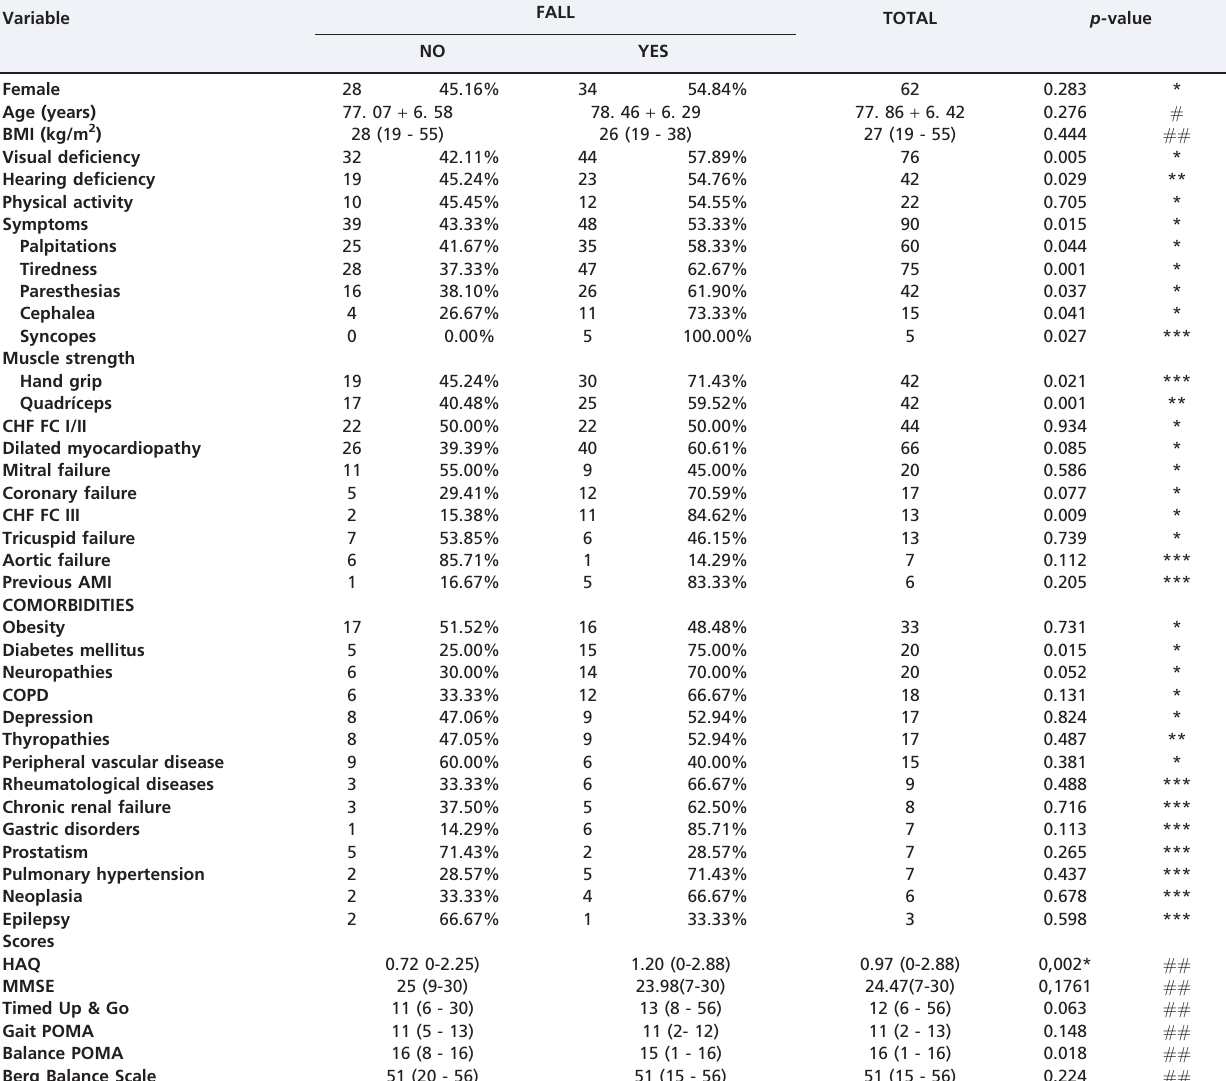
Table 1 - Characteristics and results of the elderly population with AF. Variable